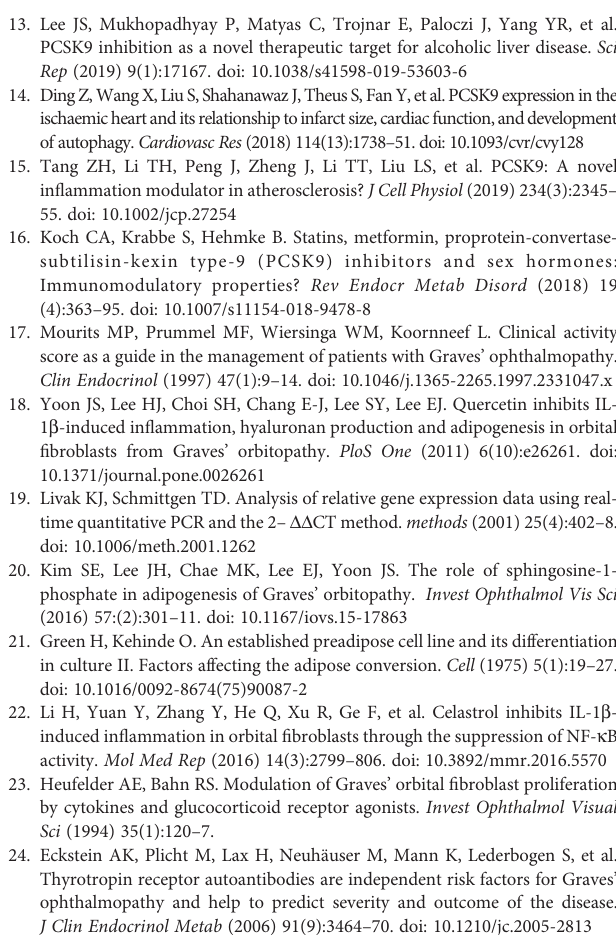
SUPPLEMENTARY FIGURE 1 | siRNA-mediated knockdown of PCSK9 in GO and non-GO fi broblasts. GO (n=3) and non-GO (n=3) orbital fi broblasts were transfected with PCSK9 siRNA (50, 100 nM) for 24 h. As shown in western blot results, the level of PCSK9 was signi fi cantly decreased following RNA interference. b - actin was included as a loading control. NC, normal control. SUPPLEMENTARY FIGURE 2 | Effect of PCSK9 siRNA on viability of GO fi broblasts. Orbital fi broblasts of GO patients (n=3) were seeded in 24-well culture plates,1×10 5 cellsperwell.PCSK9siRNA(50nM)wereapplied towellsfor 10,24, and 48 h and MTT assay was conducted to test cell viability. Results are presented as mean ± SD. Assays were carried out in triplicate and repeated at least three times. The proliferation of GO fi broblasts was impeded in PCSK9 siRNA-treated fi broblasts compared to the